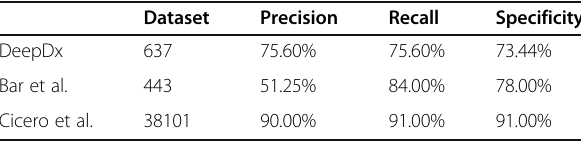
Table 4 Comparison of accuracy